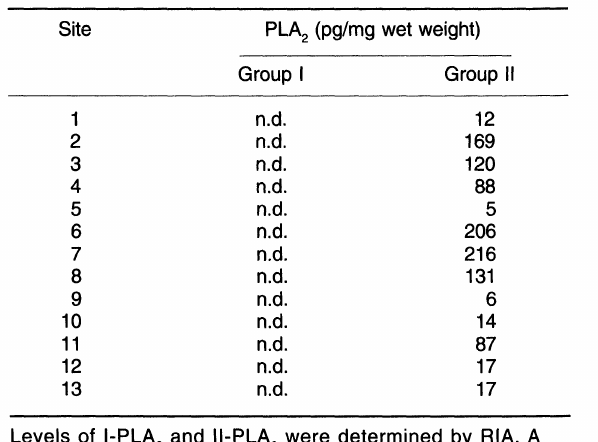
Levels of I-PLA2 and II-PLA2 were determined by RIA. A wide range of II-PLA levels was observed in gingival tissues, but no I-PLA2 was found in any of the samples tested, n.d., not